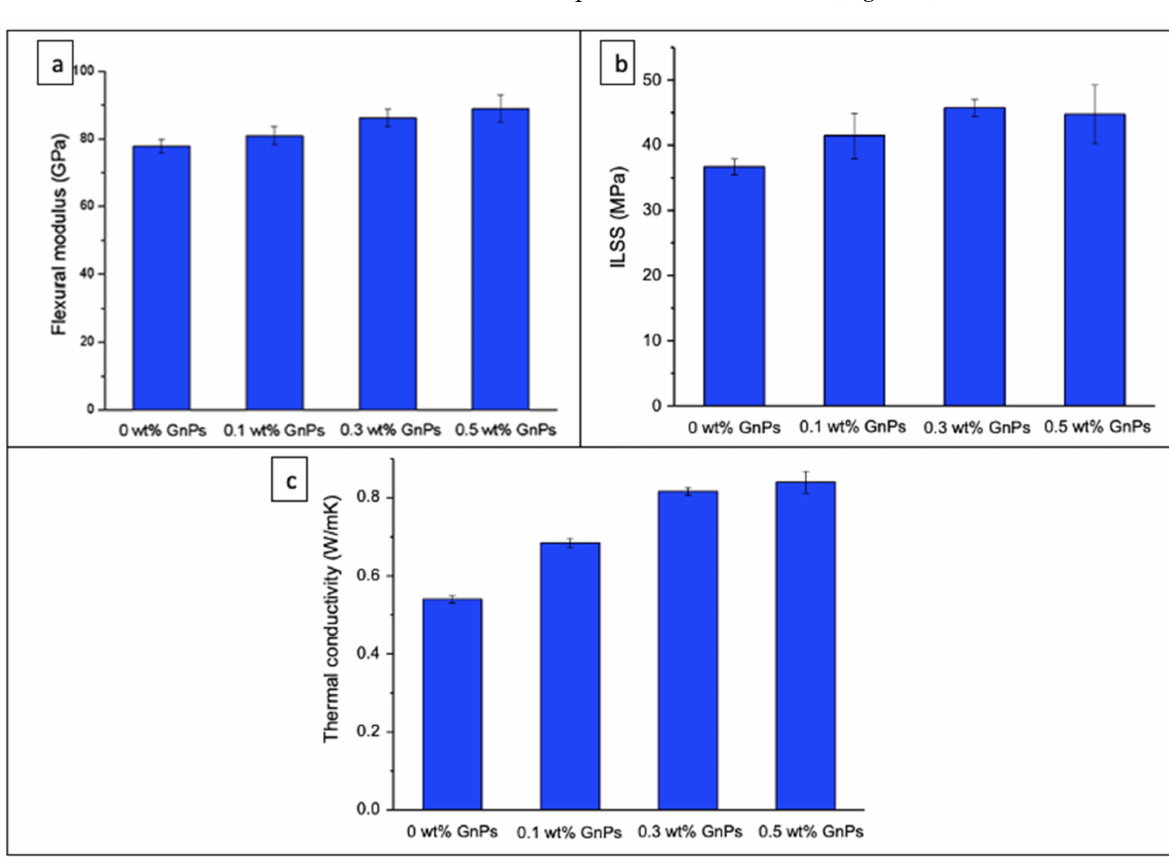
Figure 5. ( a ) Flexural strength; ( b ) interlaminar shear strength; ( c ) thermal conductivity variation at different wt.% of GNPs [55]. Obtained with permission from Journal of Materials Science; published by Springer Nature,